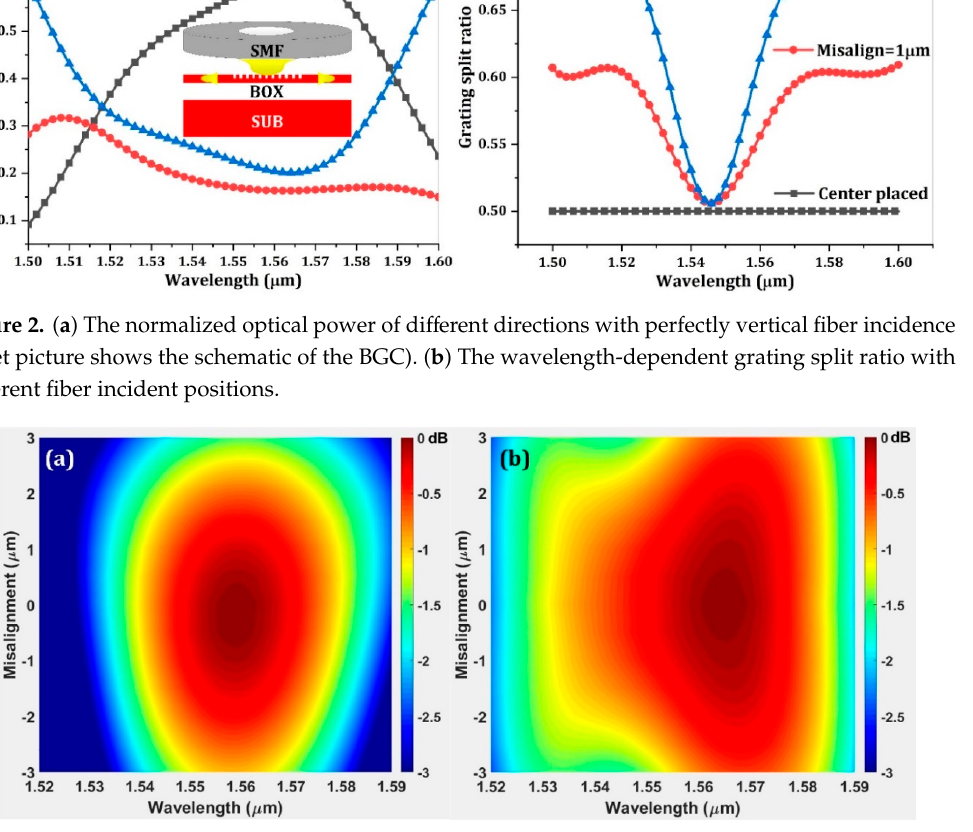
Figure 3. ( a ) The calculated coupling efficiency variation of a unidirectional grating coupler (GC) with fiber misalignment. ( b ) The calculated coupling efficiency variation of a bidirectional GC with fiber